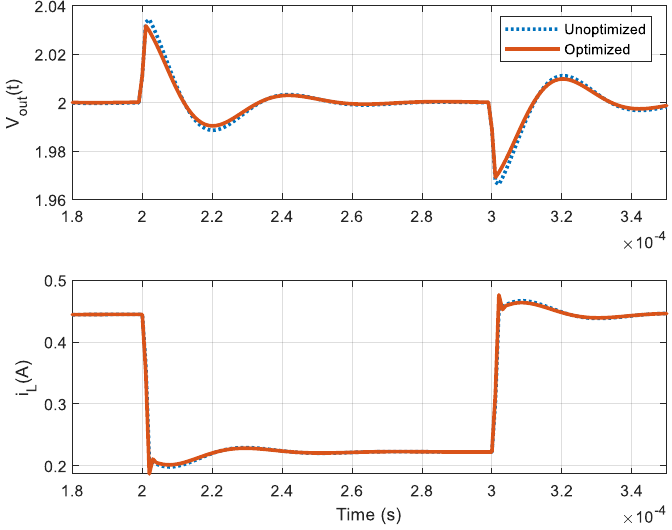
Figure 7. Load transient response offered by digital compensators.